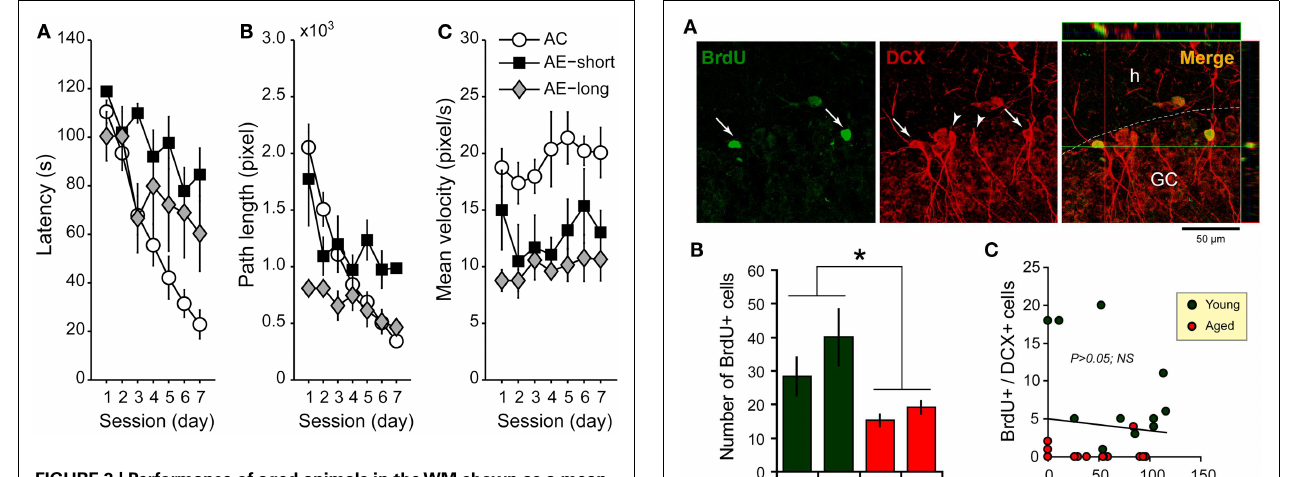
FIGURE 3 | Performance of aged animals in theWM shown as a mean of (A) latency, (B) path length, and (C) velocity to find the hidden platform, as in Figure 2. Data are represented as the means ± SEM. All aged animals learned to find the hidden platform along the sessions (Repeated-Measures ANOVA), but epileptic animals performed worse than aged control (Student Newman–Keuls post hoc test). AC (white circle): aged controls; AE-short (black square): aged with status epilepticus at 20months of age; and AE-long (gray diamond): aged with status epilepticus at 3months of age.